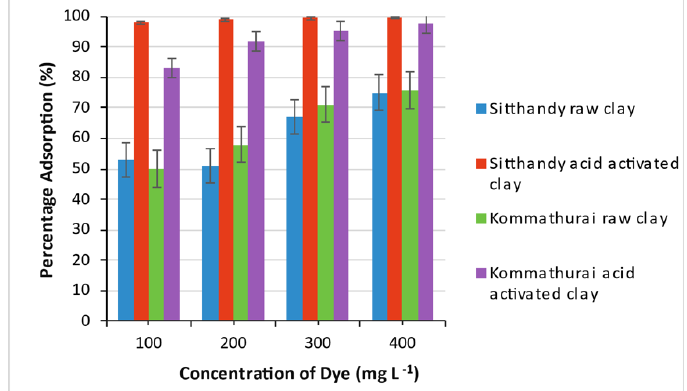
Figure 5: Effect of initial dye concentration on adsorption of Congo red by different clays (Contact time: 24 h).